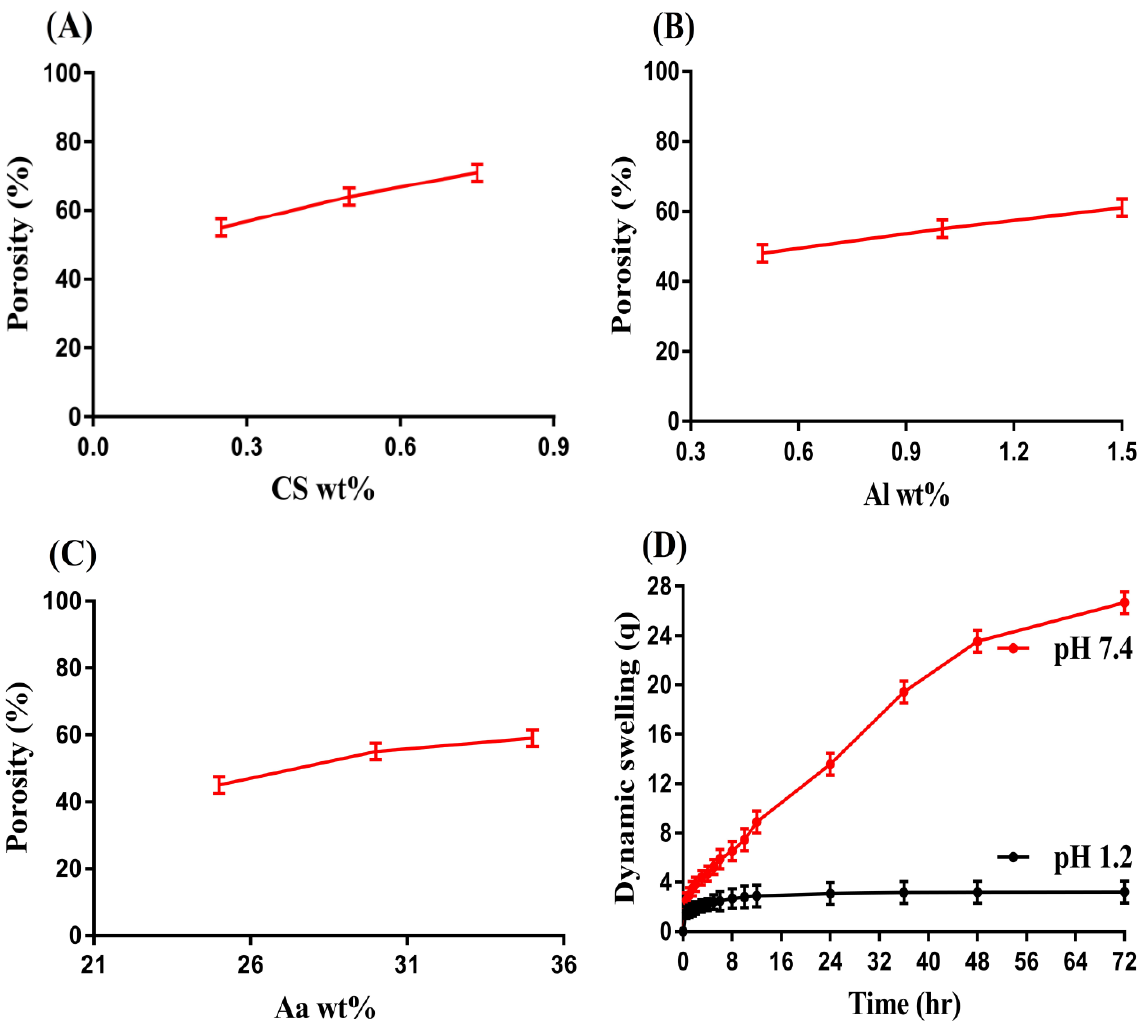
Figure 7. Effect of ( A ) CS, ( B ) Al, ( C ) and Aa on porosity of CS/Al-g-pAa hydrogel, and ( D ) effect of pH on dynamic swelling of CS/Al-g-pAa hydrogel.